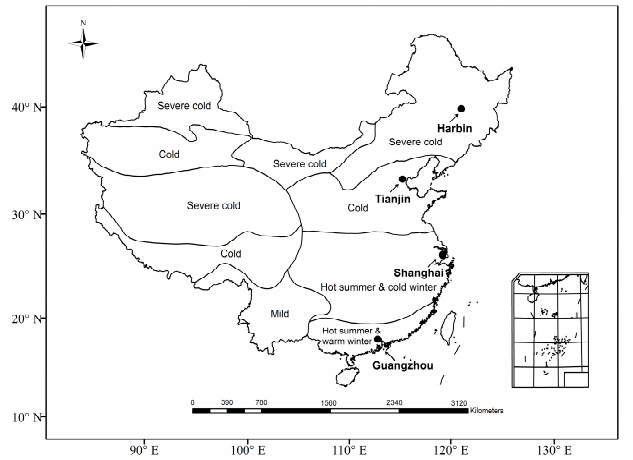
Figure 1. The major climate zones and geographical distribution of the selected representing